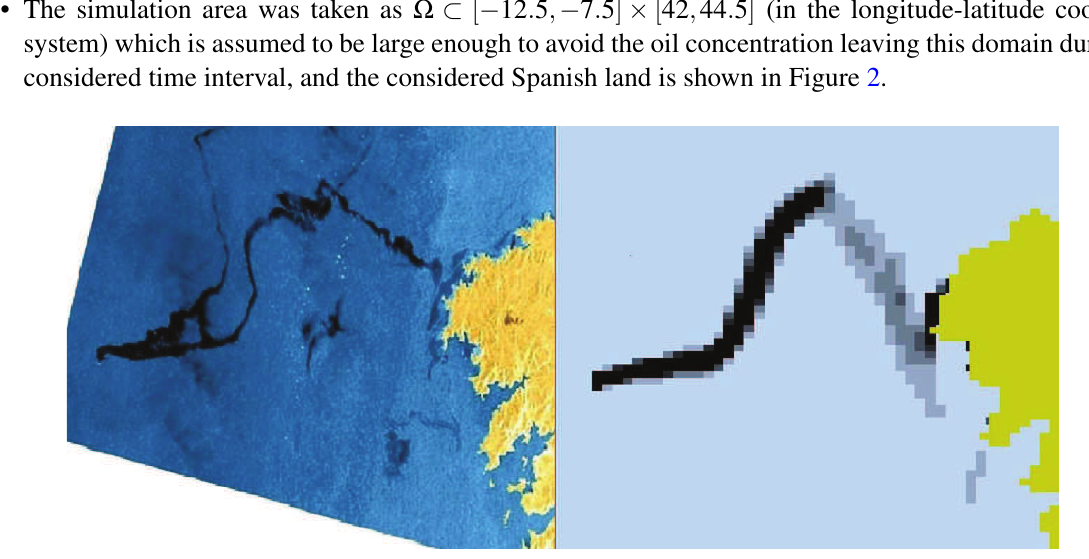
Fig. 2 (Left) Satellite image of the Prestige oil spill situation taken by the Envisat ASAR satellite (European Spatial Agency) on 17 November 2002. (Right) Oil concentration simulated by the model presented in this work for the same date. The coast is also represented in